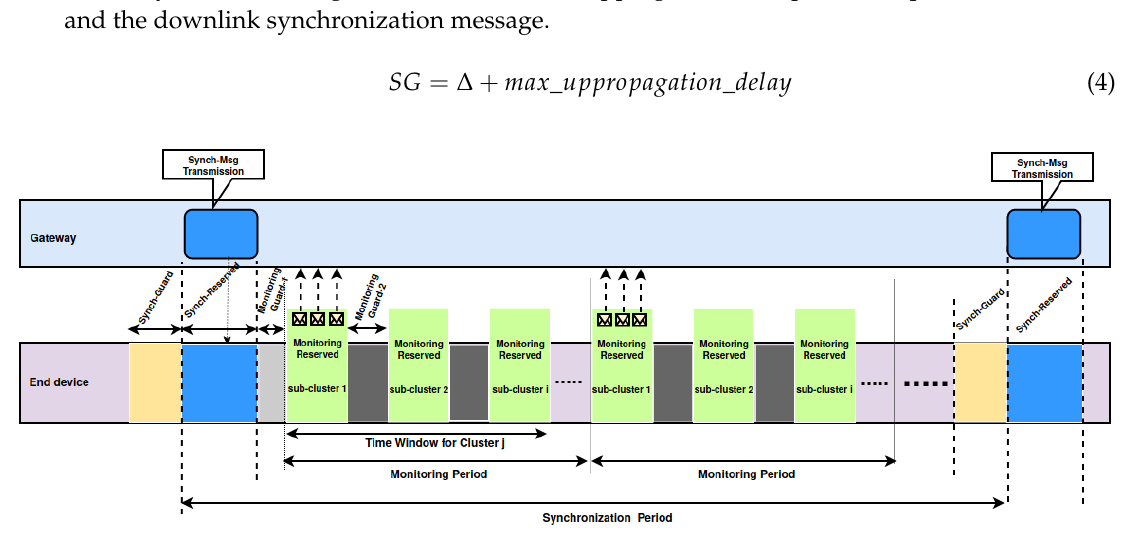
Figure 5. Medium activity over